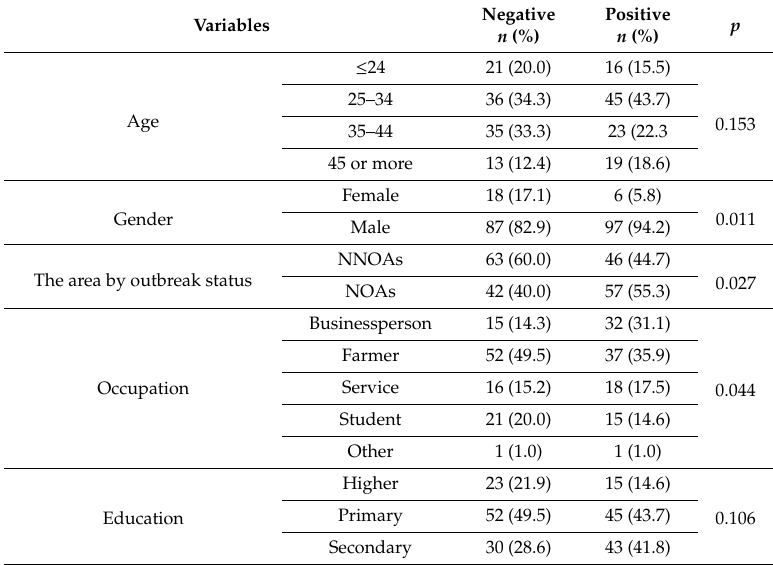
Table 3. Test of statistical significance of variation in the respondents’ knowledge, attitudes, and perceptions of the ecology and myths of bats by their